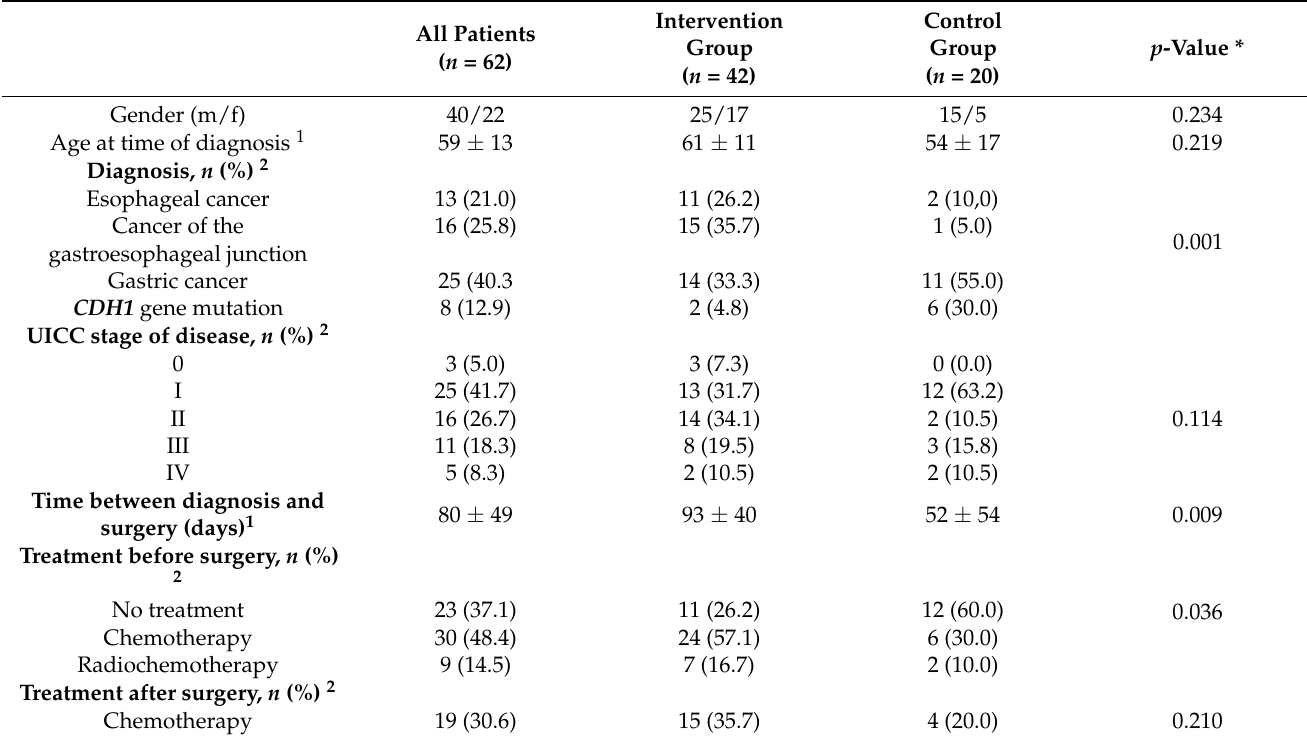
Table 1. Characteristics of the study